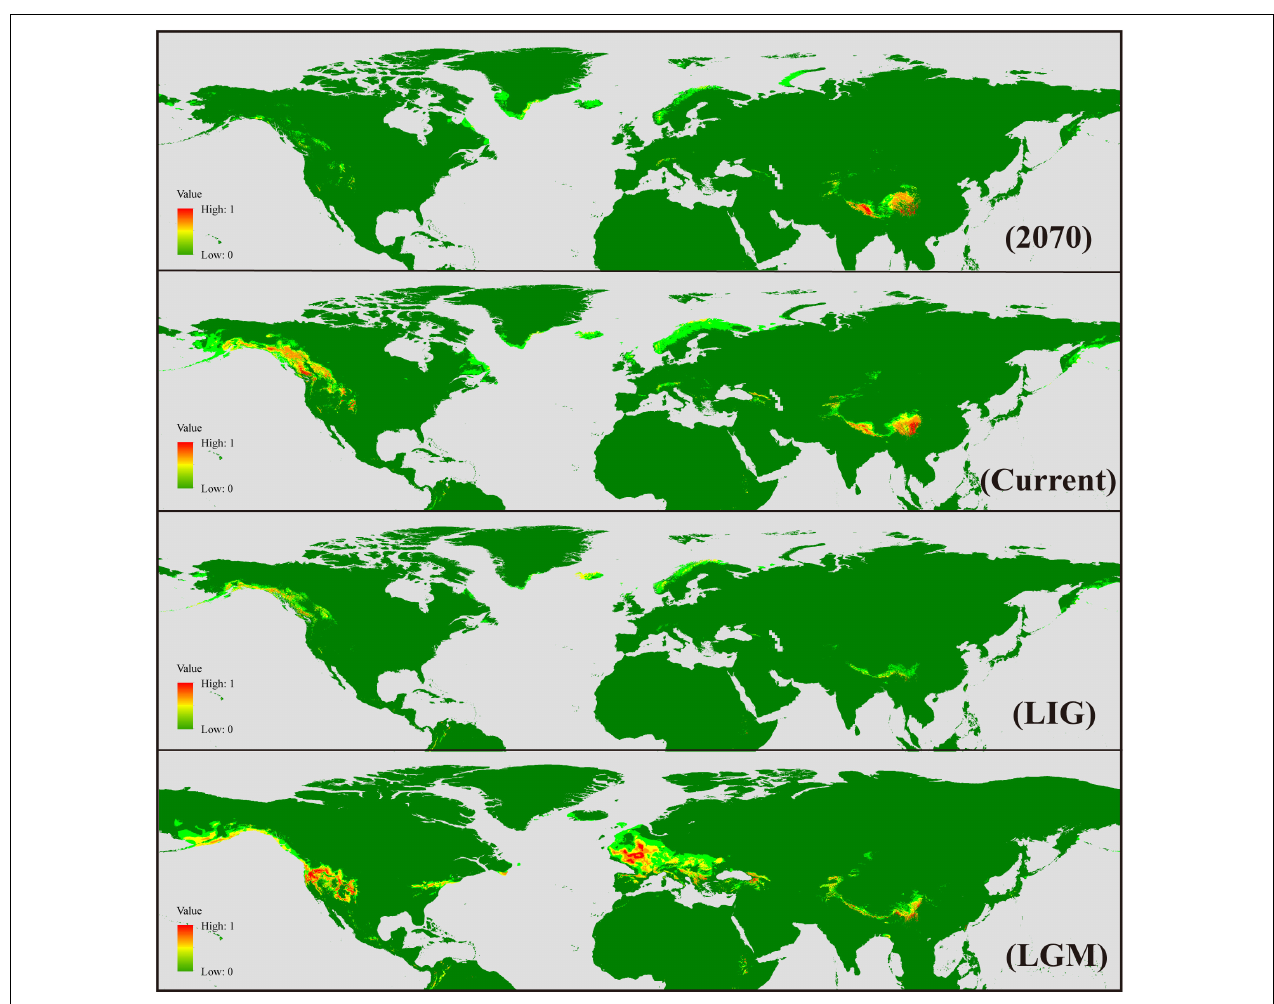
FIGURE 5 | Geographical distribution models showing climatic suitability for Sibbaldia procumbens s.l. for 2070, present time, last interglacial (LIG), and last glacial maximum